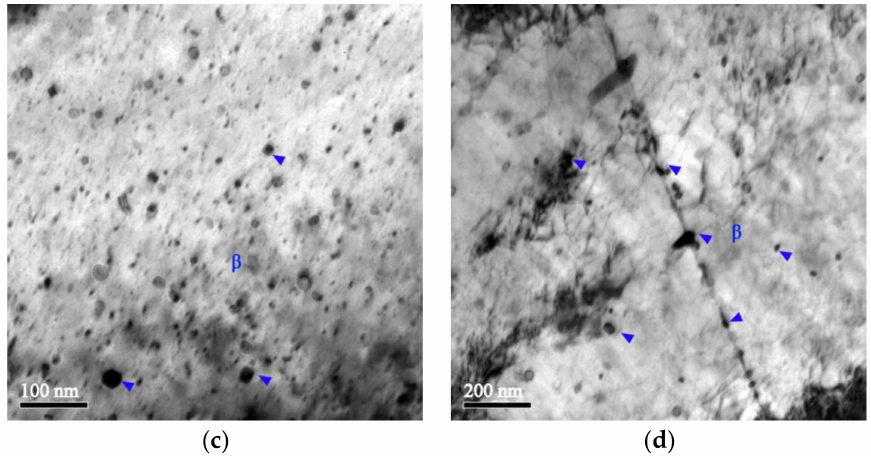
Figure 6. BF micrographs of Cu-Cr-Zr alloys with 60-min-annealed states at different temperatures: ( a , b ) 823 K and ( c , d ) 873 K.